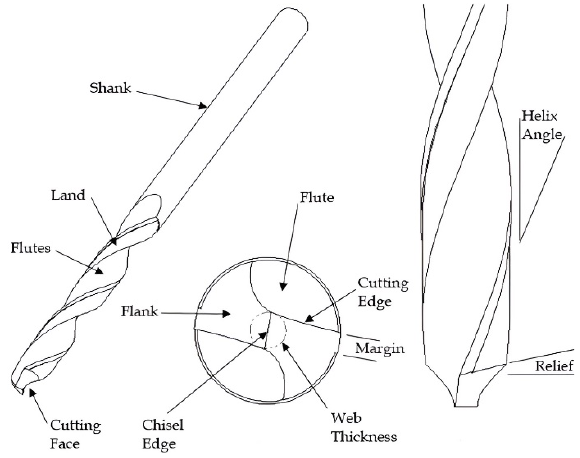
Figure 14. Geometry of conventional twist drill [174].